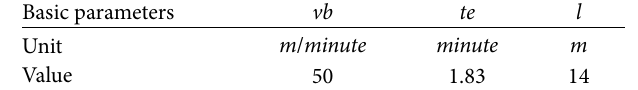
Algorithm and the Genetic Algorithm respectively to resolve